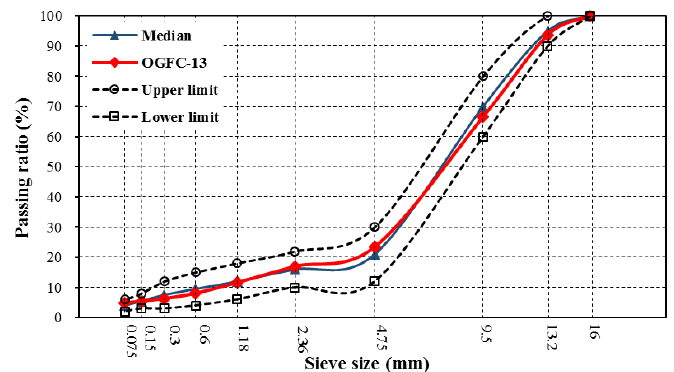
Figure 3. Gradation curve of open-graded friction course (OGFC)-13 asphalt mixture.